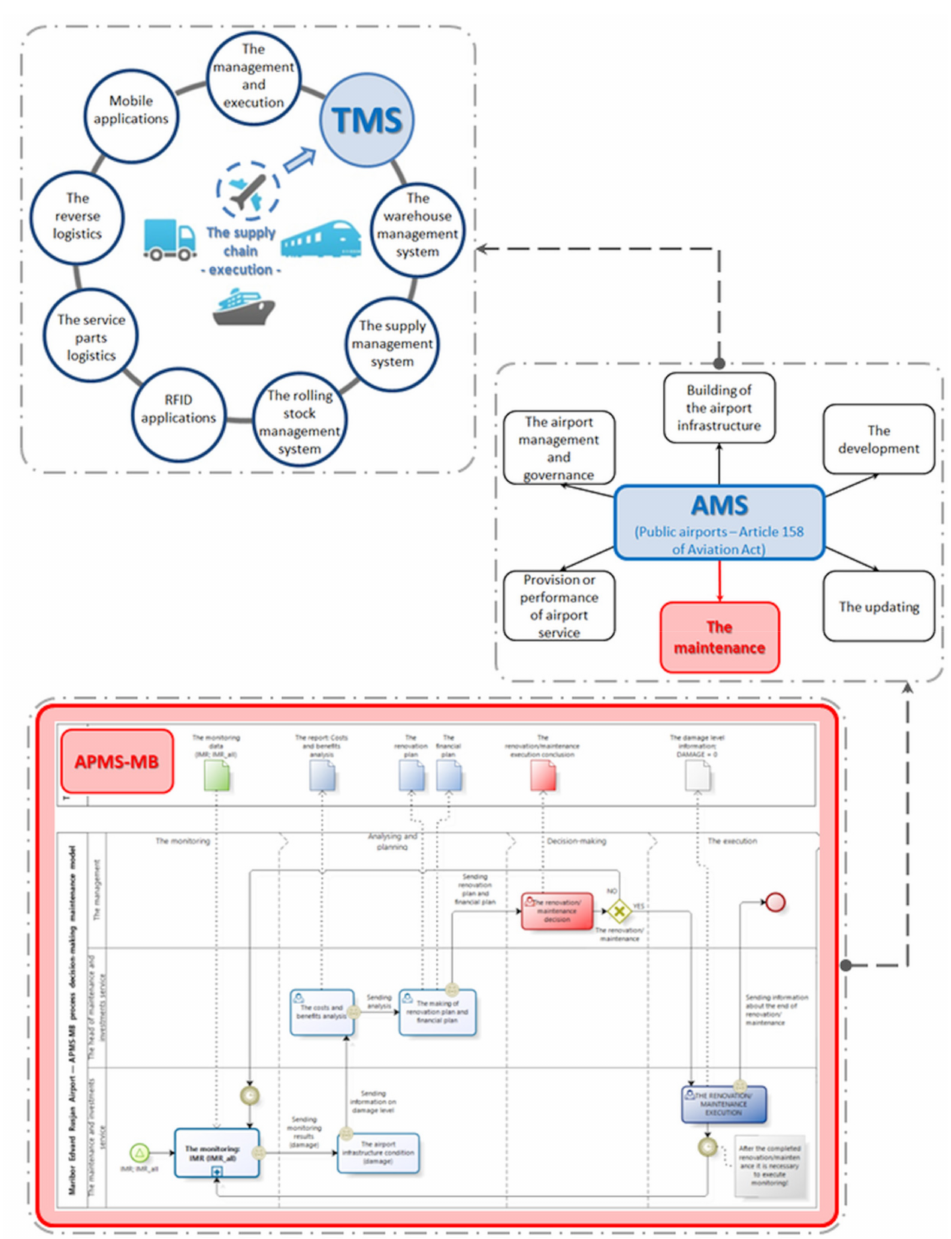
Figure 3. Integration of the APMS-MB model with AMS and more widely with the